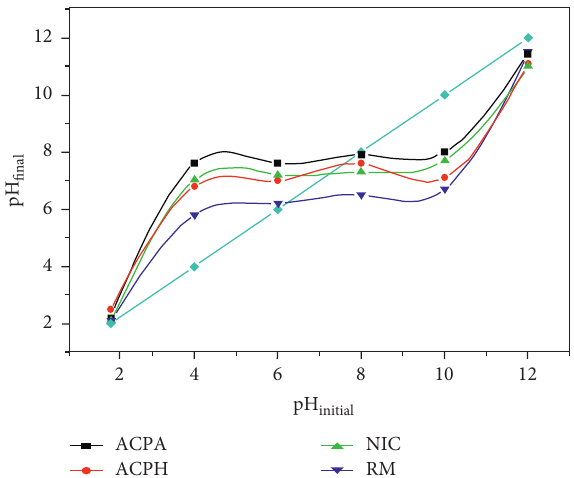
Figure 4: Determination of pHzpc of different adsorbents.